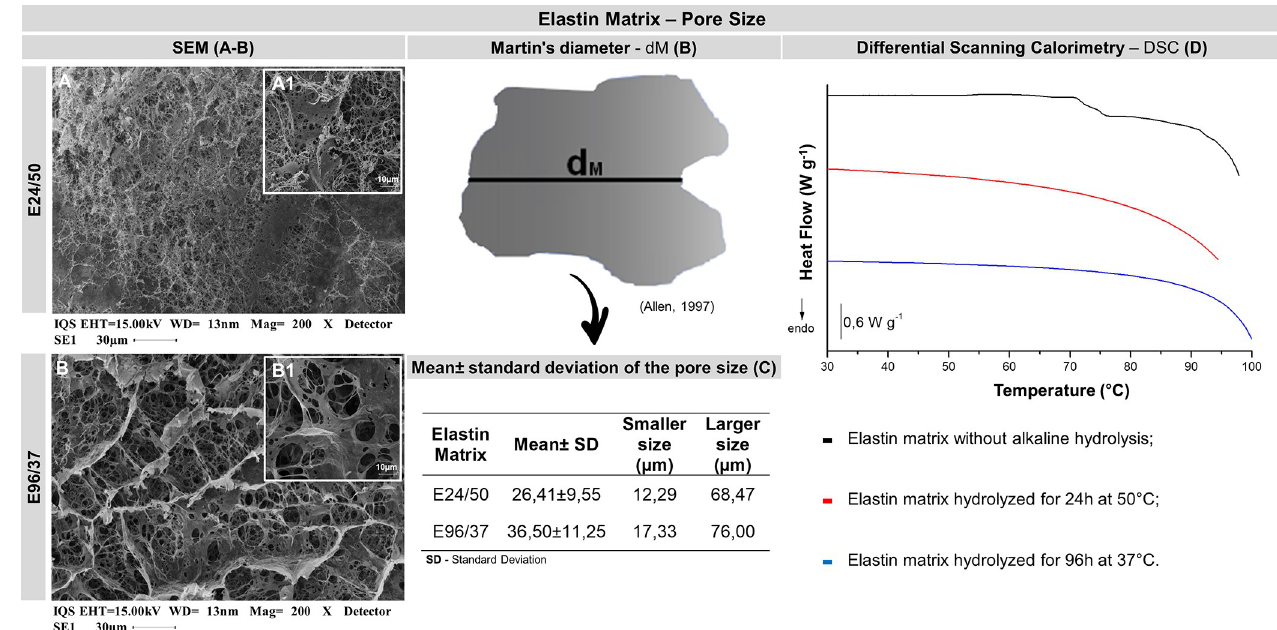
Fig 3. Elastin matrix–pore size. ( A, B ) Scanning electron microscopy images of elastin matrix surfaces in different magnifications 200x and 1000x, respectively. ( B ) The pore diameters were measured in SEM photomicrographs using an approximation of the diameter of Martin [12]. ( C ) Table of the mean + standard deviation of the pore size of the elastin matrices E24/50 and E96/37 and the sizes of the smallest and largest pores. SEM image 1000x magnification [11]. ( D ) Differential Scanning Calorimetry (DSC) curves of elastin matrices with or without alkaline hydrolysis.